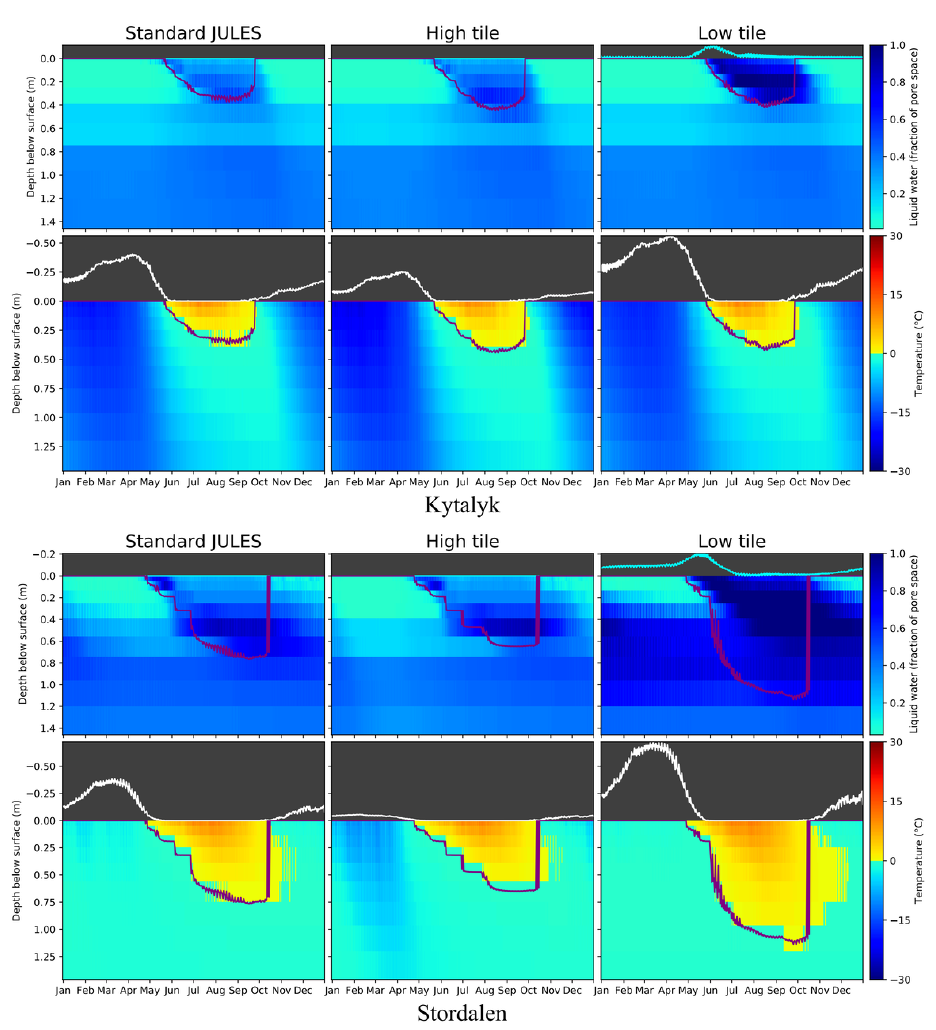
Figure B6. Climatologies (2002–2016) providing a comparison of observations with standard and tiled (no qbase) JULES for the polygon site Kytalyk and the palsa site Stordalen. The white line above the plots of soil temperature shows simulated snow depth, the cyan line above the plots of simulated soil moisture shows simulated pond depth, and the purple line shows thaw